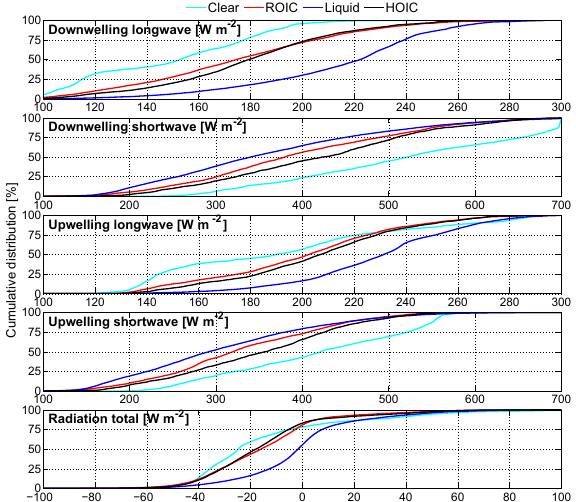
Figure 7. Cumulative distribution function of downwelling and up- welling radiation data at the surface parsed by CAPABL column classification